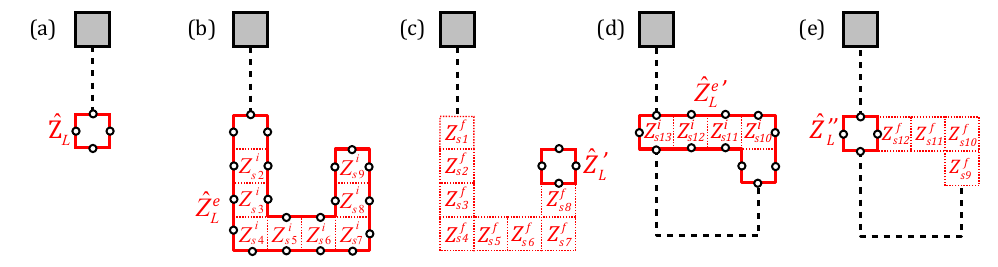
Figure 36: Braid transformation of a Z cut qubit with Z in red; data qubits are open circles; dashed line linking the two qubit L holes does not represent an operator. (b) Extended opening (solid red loop) for first move in braid. The pre-move Z stabilizer outcomes Z i erator (solid red loop) is extended from Z